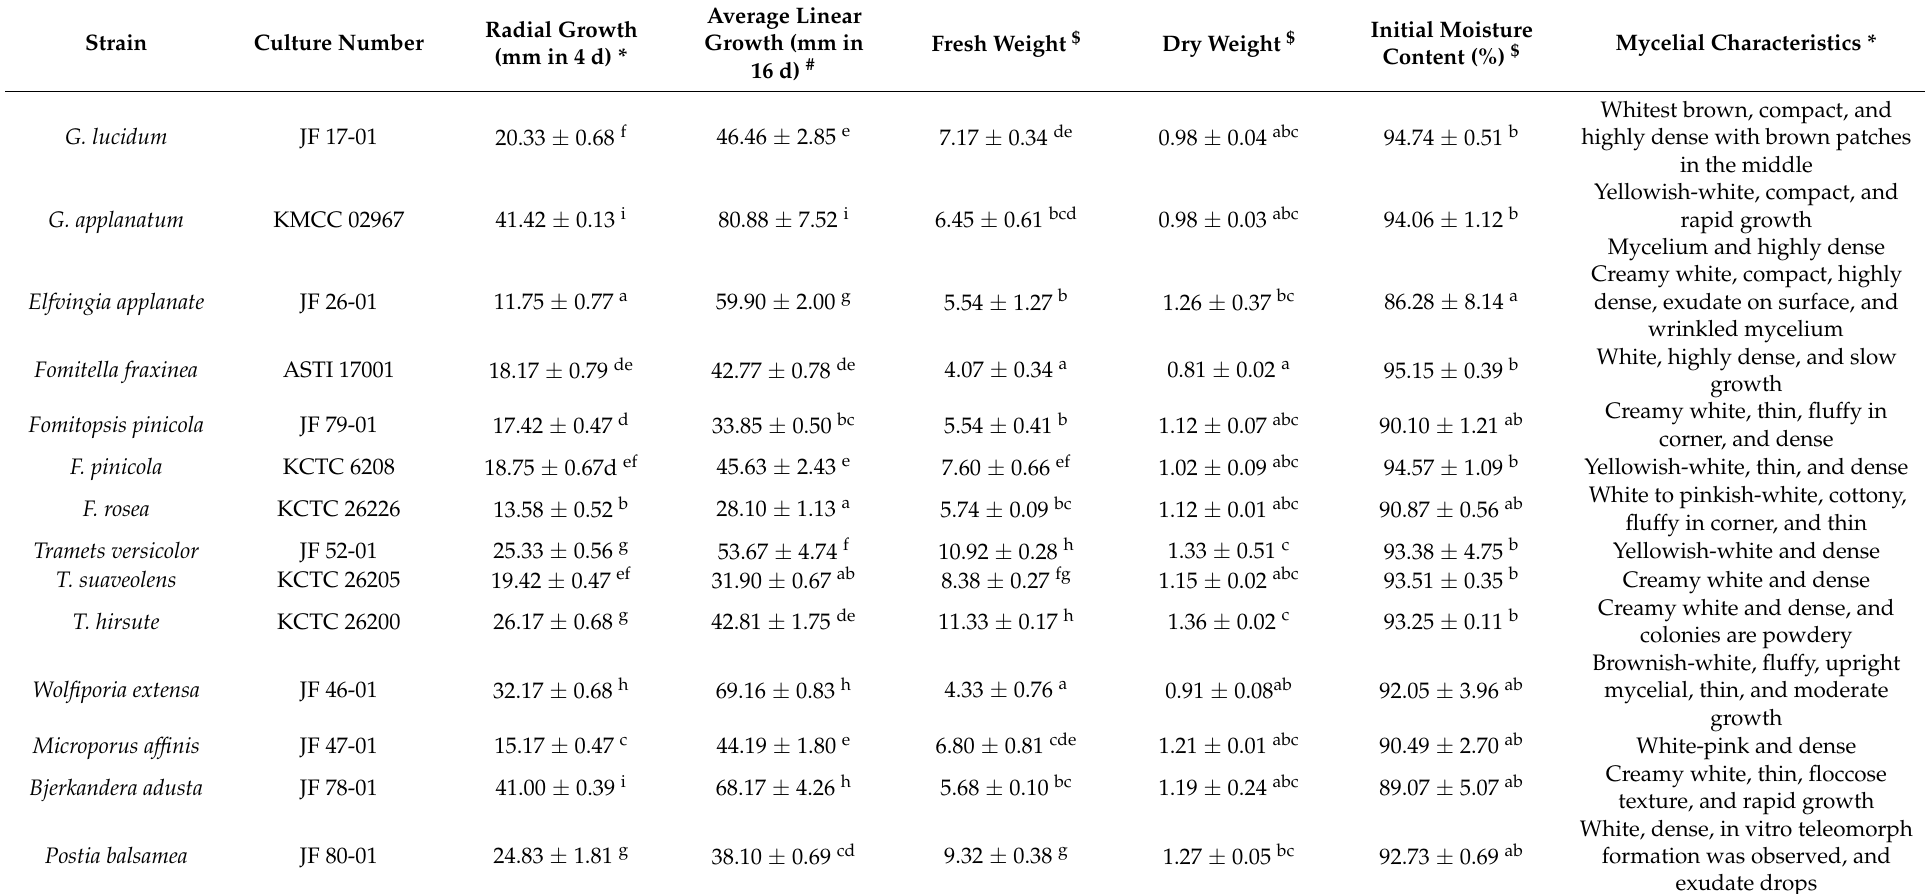
Table 1. Colony morphology, growth rate, and characteristics of Polyporales